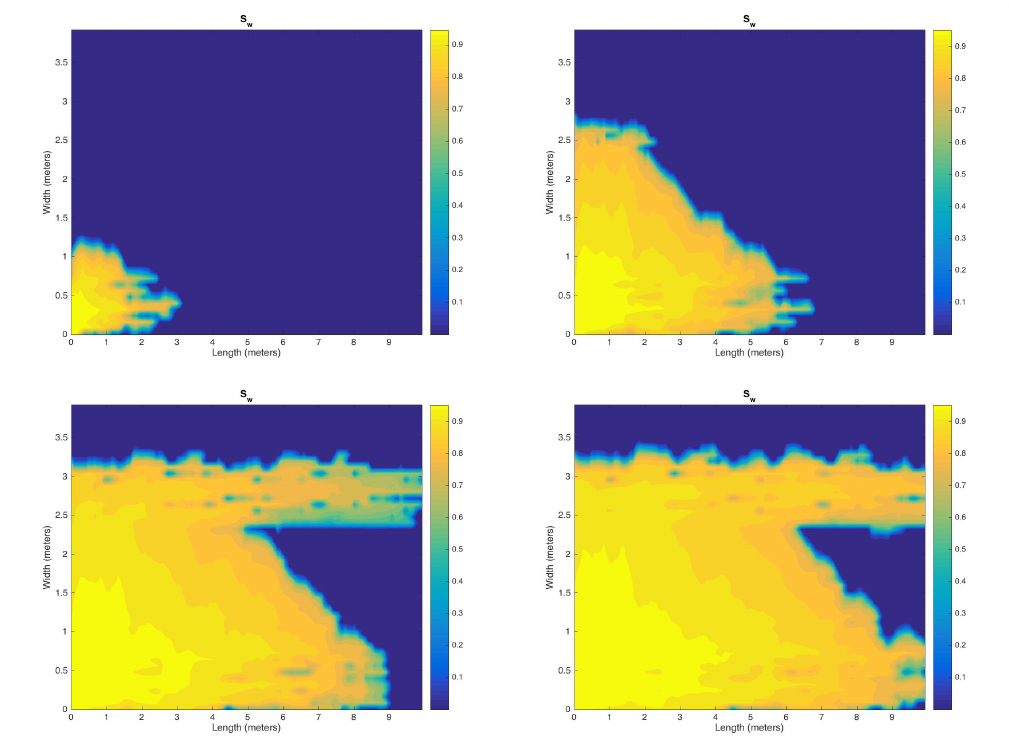
Figure 1. Distribution of the saturation on heterogenous permeability map after 0.35, 0.5, 0.75, and 0.85 pore volume (PV).